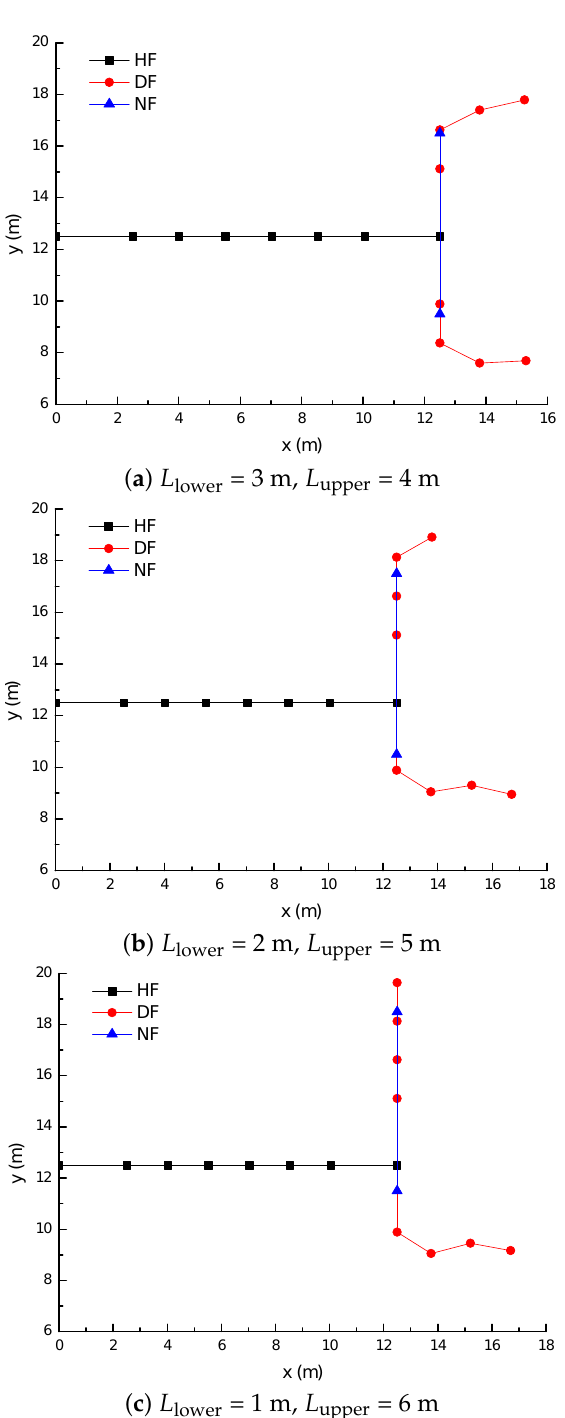
Figure 5. The crack propagation paths at different lengths of lower and upper parts of the NF. In this figure, the black, blue, and red dotted lines, respectively, denote the original HF, the initial NF, and the diverted fracture